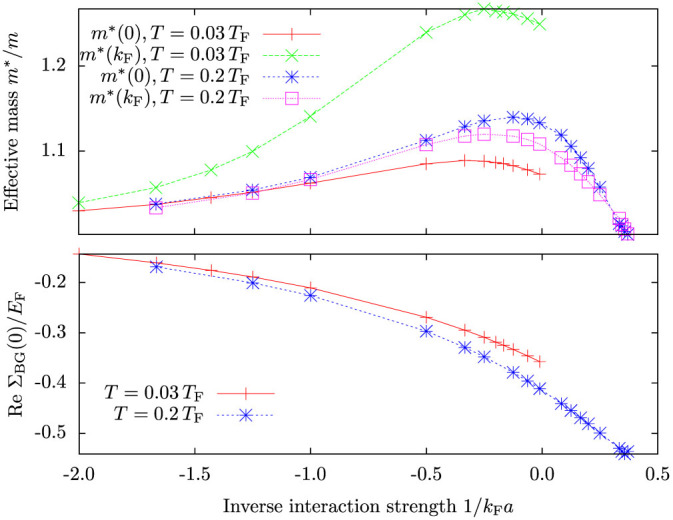
Top: the effective mass m*/m obtained from the Brueckner-Goldstone self-energy for zero momentum atoms and atoms at the Fermi surface. The zero momentum effective mass is obtained using a quadratic fit to the self-energy, and the effective mass at the Fermi surface using a linear fit as exemplified in Fig. 2. The T = 0.2 TF data for k = 0 shows the error bars from the fitting. Bottom: the energy shift of zero-momentum atoms Re ΣBG(k = 0) as a function of interaction strength. Notice that the data for different temperatures has not been calculated beyond the point where the perturbative extension of the Brueckner-Goldstone model starts exhibiting nonphysical artifacts in the momentum distribution, see main text. The model works better at higher temperatures.